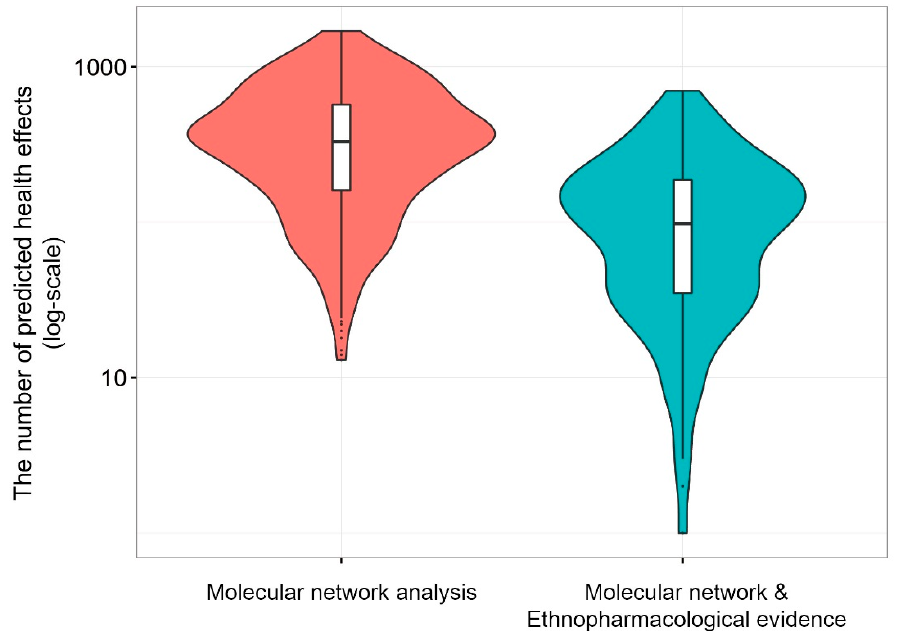
Figure 3. The distribution of the number of predicted health effects. The distribution of the number of predicted health effects by molecular network analysis (red violin plot). The mean of predicted health effects is 415.6 ± 27.3. Next, we investigated the intersection between predicted health effects of the phytochemicals and ethnopharmacological use of the plant containing the phytochemicals. The distribution of the number of predicted health effects by molecular network analysis and ethnopharmacological use evidence (blue violin plot). The mean of predicted health effects is 129.1 ± 11.4.